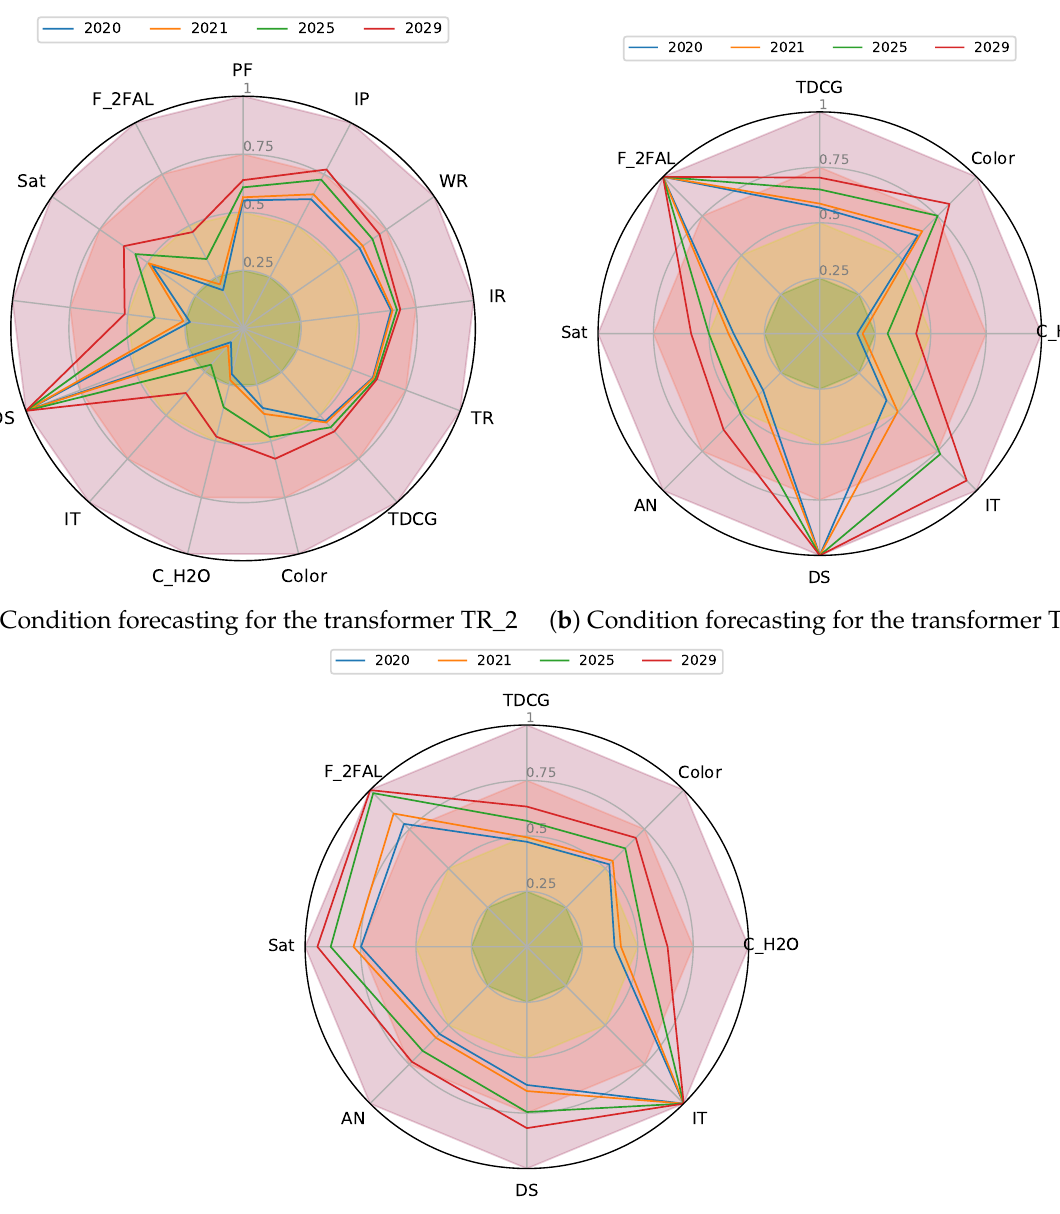
Figure 6. Normalized diagnostic condition assessment of the power transformer fleet of IEEE 36 Bus System transmission, where C_H20, PF, IP, WR, IR, TR, IT, AN, and SAT are water content, power factor, polarization index, winding resistance, insulation resistance, winding ratio, interfacial tension, acidity,and relative saturation,